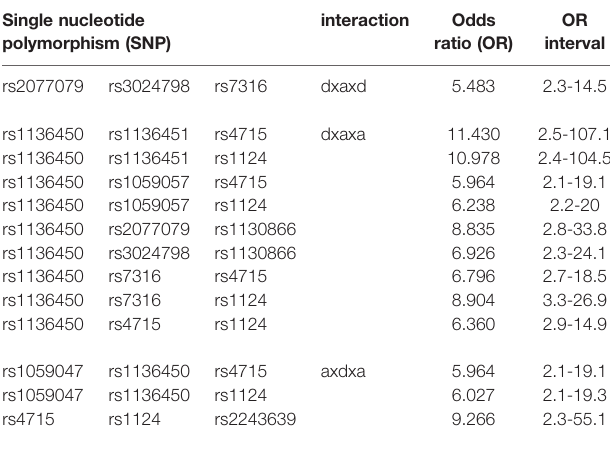
TABLE 5 | SNP interactions associated with IPF with odds ratio higher than 5. Single nucleotide polymorphism (SNP)